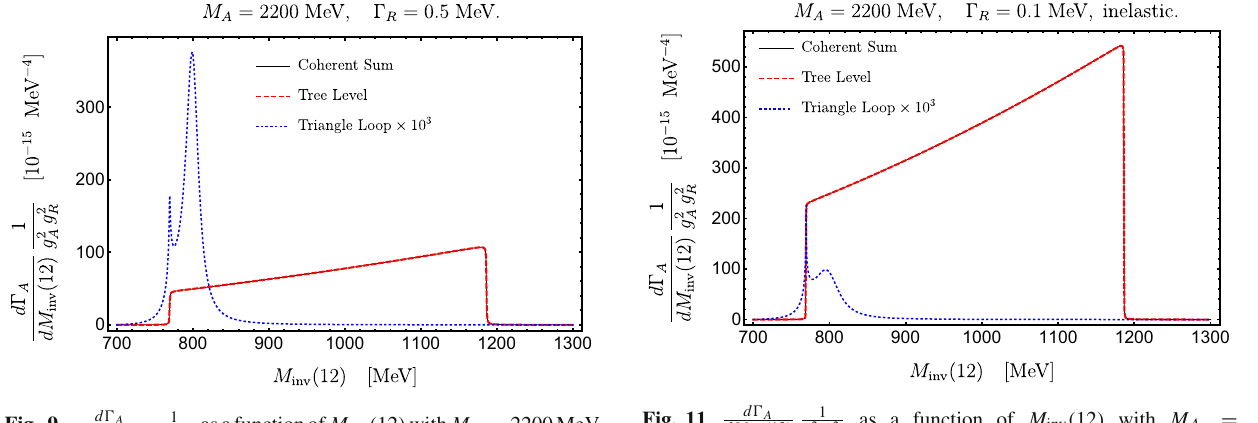
12000100200300400500